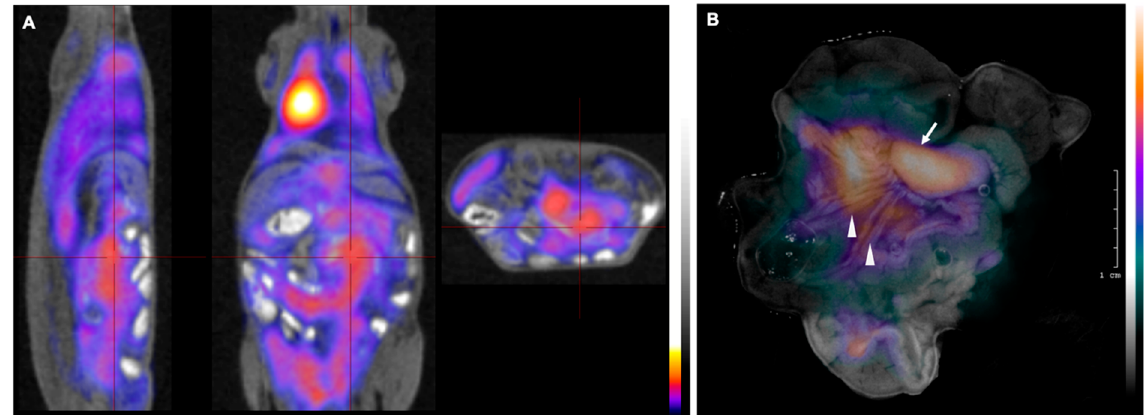
Figure 3. PET/MRI images of Bc-DLFL.1 lymphoma cell biodistribution in the advanced stage. PET/MRI images of Bc.DLFL1 cell biodistribution at advanced lymphoma stage after intraperitoneal tumor inoculation detected by intravenous FDG injection (administered 1 h earlier) show several mesenteric lymph nodes accumulating ( A ). After subsequent removal, the abdominal organs were subjected to CLI ex vivo. Panel B shows superimposed white and Cerenkov light pictures. The arrow indicates extensive FDG accumulation in the mesenteric lymph node conglomerates (arrow). In addition to mesenteric lymph nodes, CLI also detected the lymphoma expansion within mesenterial fatty streaks (arrowheads) ( B ).